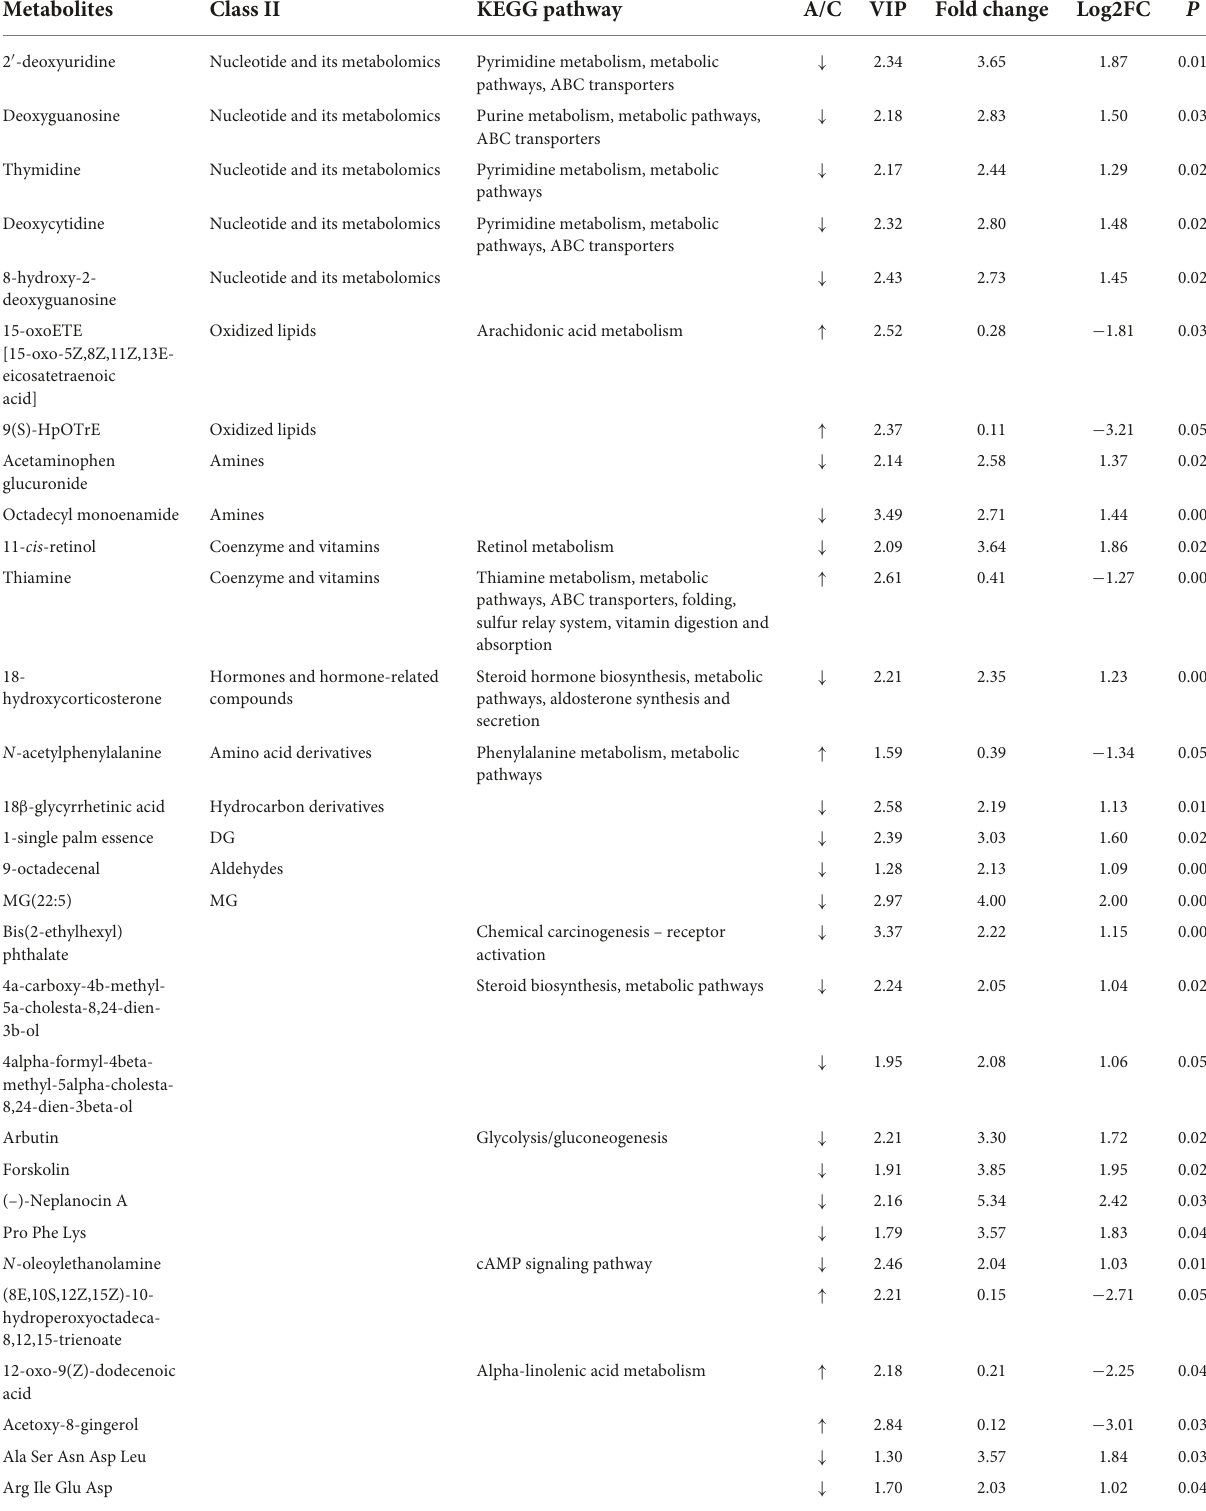
TABLE 1 Differential metabolites and the relevant KEGG